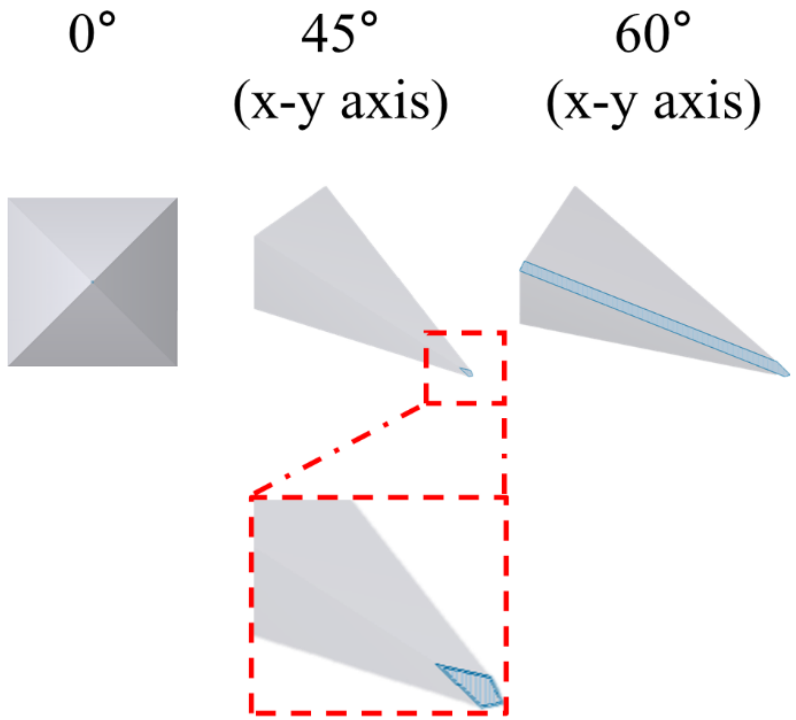
Figure 7. Schematic images of the single stacking layer area, including the microneedle tip at the printing angles 0 ◦ , 45 ◦ , and 60 ◦ , for both x and y axes. Table 3. The area of the single stacking layers, including the microneedle tip at the printing angles 0 ◦ , 45 ◦ , and 60 ◦ , for both x and y axes.